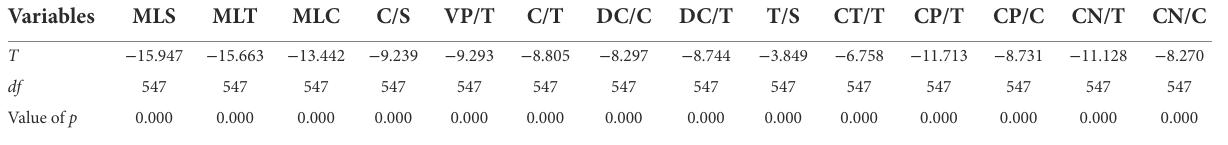
TABLE 5 Independent sample